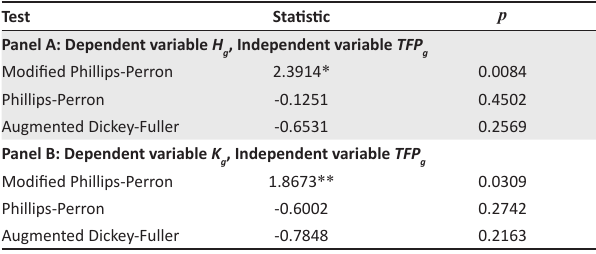
TABLE 8: Pedroni cointegration test results.